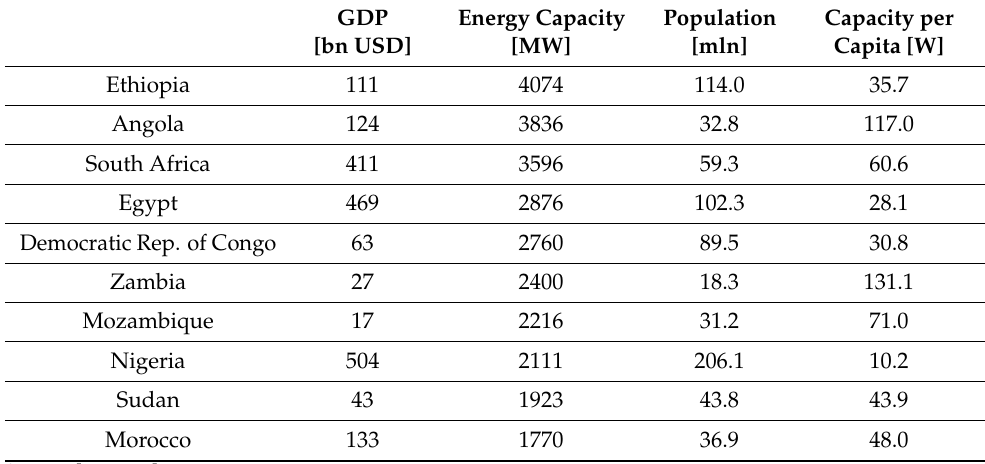
Table 3. Ten African countries with the highest installed hydropower capacity